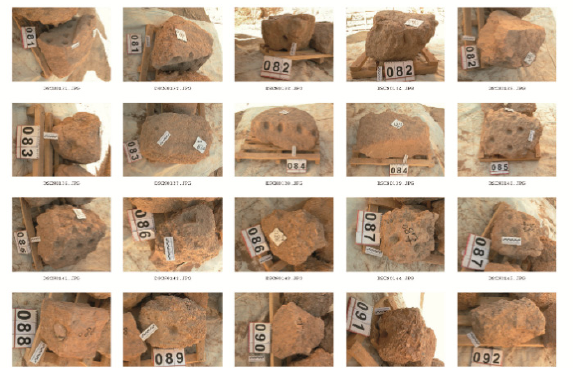
Figure 8. Example of salvaged fragments originating from